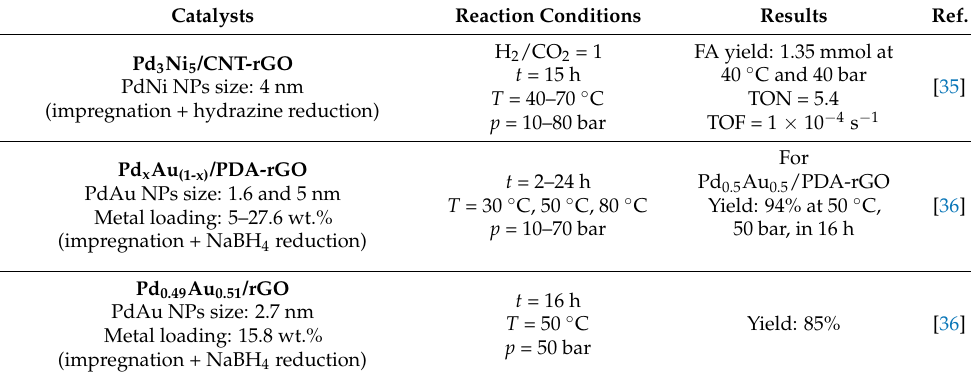
Table 3. Graphene-based catalysts for CO 2 hydrogenation to formic